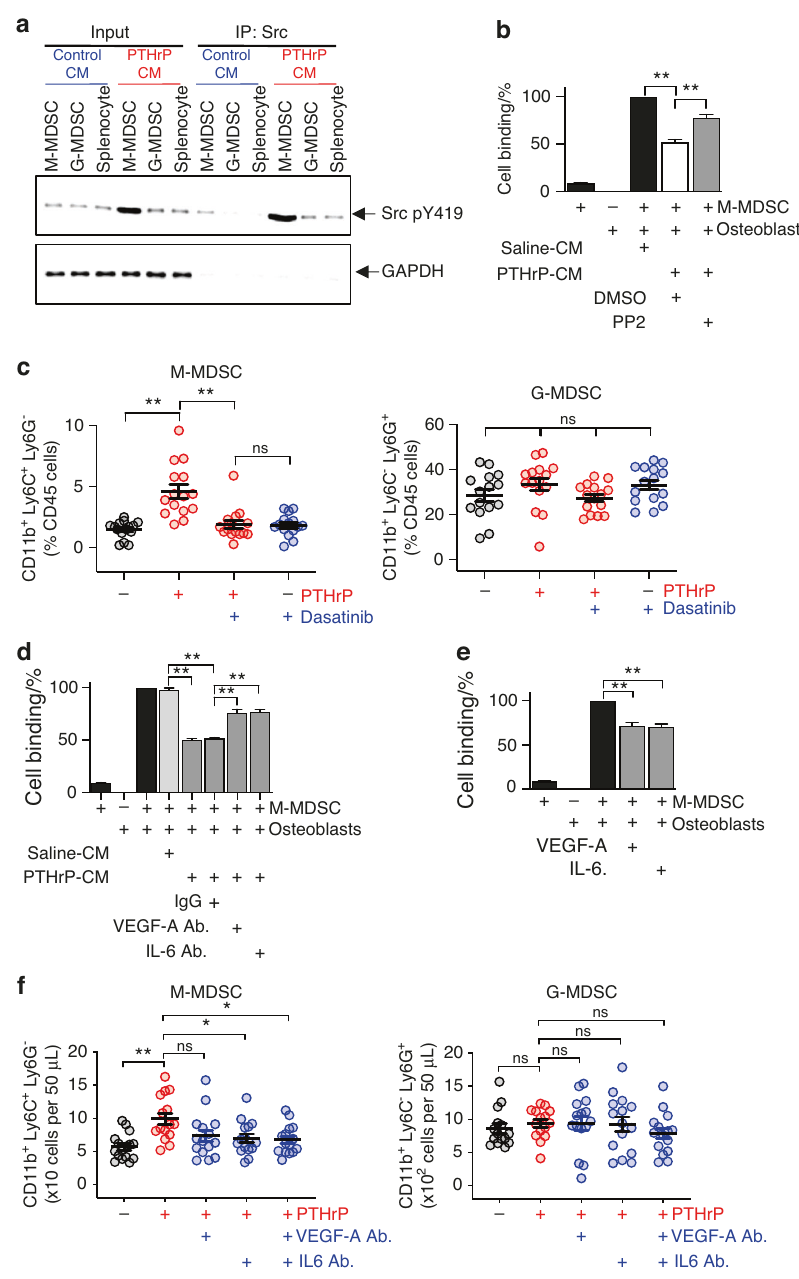
Fig. 7 Src family kinase activation via VEGF-A and IL6 in M-MDSCs is required for releasing M-MDSCs from osteoblasts. a PTHrP-conditioned media from osteoblasts induced activating phosphorylation of Src family kinase (SFK) at the Y419 residue in M-MDSCs but not in G-MDSCs or splenocytes. b In vitro cell binding assay showing that an SFK-speci fi c inhibitor, PP2, reversed the effects of PTHrP-conditioned media on M-MDSC binding release from osteoblasts. CFSE-stained M-MDSCs were cocultured with osteoblasts for 2 h before washing away the unbound cells and measuring the fl uorescence intensity. DMSO was used as a vehicle control. Data are the mean ± SEM ( n = 3 per group). ** P < 0.01, one-way ANOVA with multiple group comparisons. c Dasatinib, an SFK tyrosine kinase inhibitor, suppressed PTHrP(1-34)-induced M-MDSC mobilization in vivo. Female Balb/C mice were injected with rhPTHrP (1-34; 80 µg·kg − 1 ) ± dasatinib (15 mg·kg − 1 , P.O.), followed by fl ow cytometric quanti fi cation of M- and G-MDSCs in blood. Data are from a total of three independent in vivo experiments ( n = 5 per group × 3 experiments). Dots represent individual samples, and horizontal lines represent the mean ± SEM. ** P < 0.01; ns nonsigni fi cant; Mann ‒ Whitney U test. d The effects of PTHrP-conditioned media on MDSC-osteoblast binding were reversed by the addition of anti-VEGF-A (2 μ g·mL − 1 ) or anti-IL6 (2 μ g·mL − 1 ) antibodies, two osteoblastic cytokines inducing SFK phosphorylation in MDSCs. CFSE-stained M-MDSCs were cocultured with osteoblasts for 2 h before washing away the unbound cells and measuring the fl uorescence intensity. Data are the mean ± SEM ( n = 3 per group). ** P < 0.01, one-way ANOVA with multiple group comparisons. e Addition of recombinant VEGF-A (2 ng·mL − 1 ) and/or IL6 (2 ng·mL − 1 ) inhibited MDSC-osteoblast binding in vitro. Data are the mean ± SEM ( n = 3 per group). ** P < 0.01, one-way ANOVA with multiple group comparisons. f Anti-VEGF-A or anti-IL6 antibodies suppressed PTHrP(1-34)-induced M-MDSC mobilization in vivo. Female Balb/C mice were injected with rhPTHrP (1-34; 80 µg·kg − 1 ) ± anti-VEGF-A (5 mg·kg − 1 , I.P.) and/or anti-IL6 (10 mg·kg − 1 , I.P.) antibodies, followed by fl ow cytometric quanti fi cation of M- and G-MDSCs in blood. Dots represent individual samples, and horizontal lines represent the mean ± SEM ( n = 15 per group). * P < 0.05; ** P < 0.01; ns nonsigni fi cant; Mann ‒ Whitney U